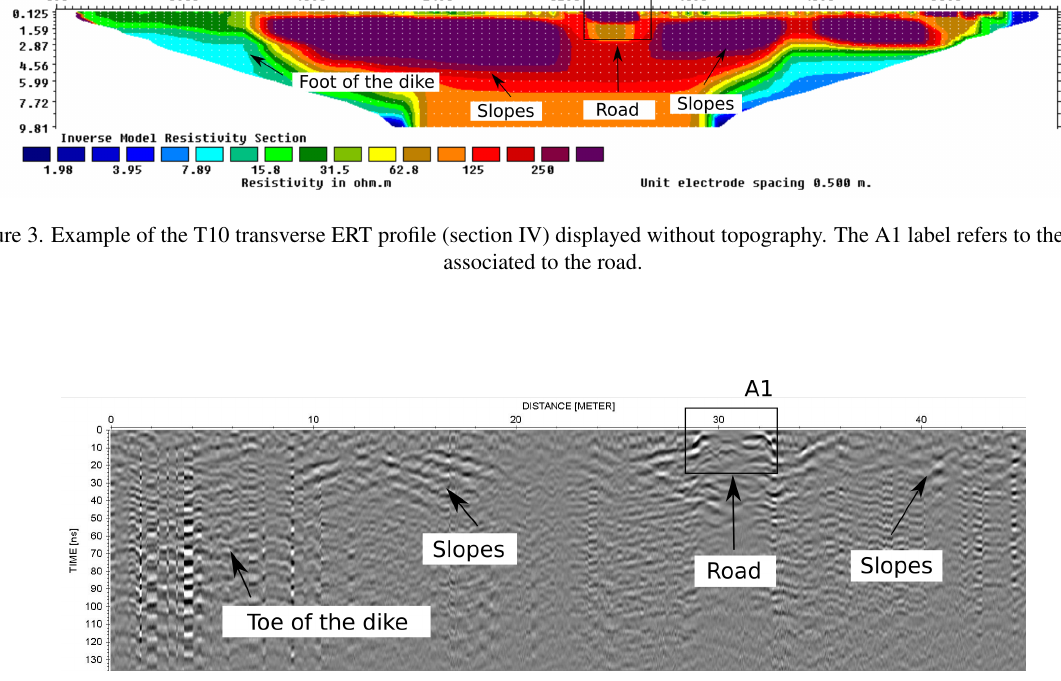
Figure 4. Example of the radargram done along the T10 profile (section IV) and displayed without topography. The A1 label refers to signal associated to the